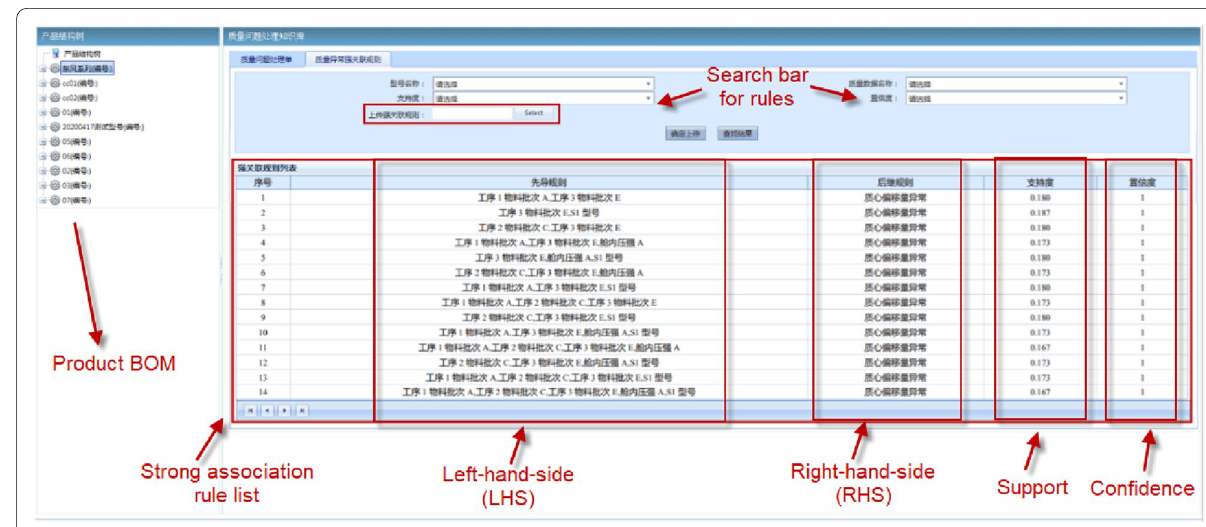
Figure 15 Strong association rules for quality